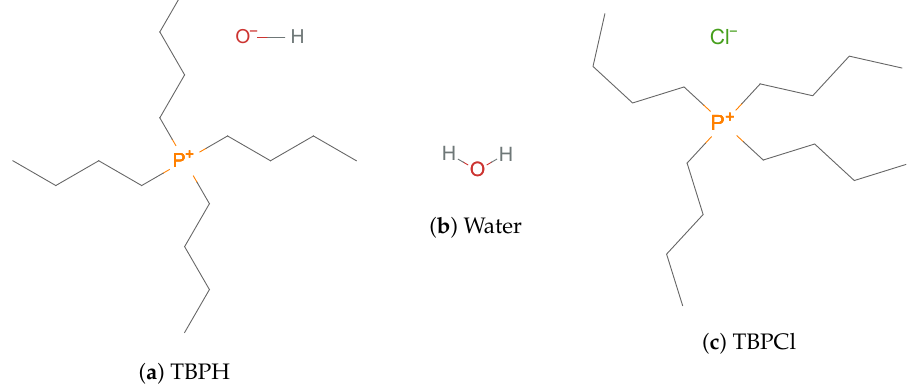
Figure 2. Chemical structures of the molecules